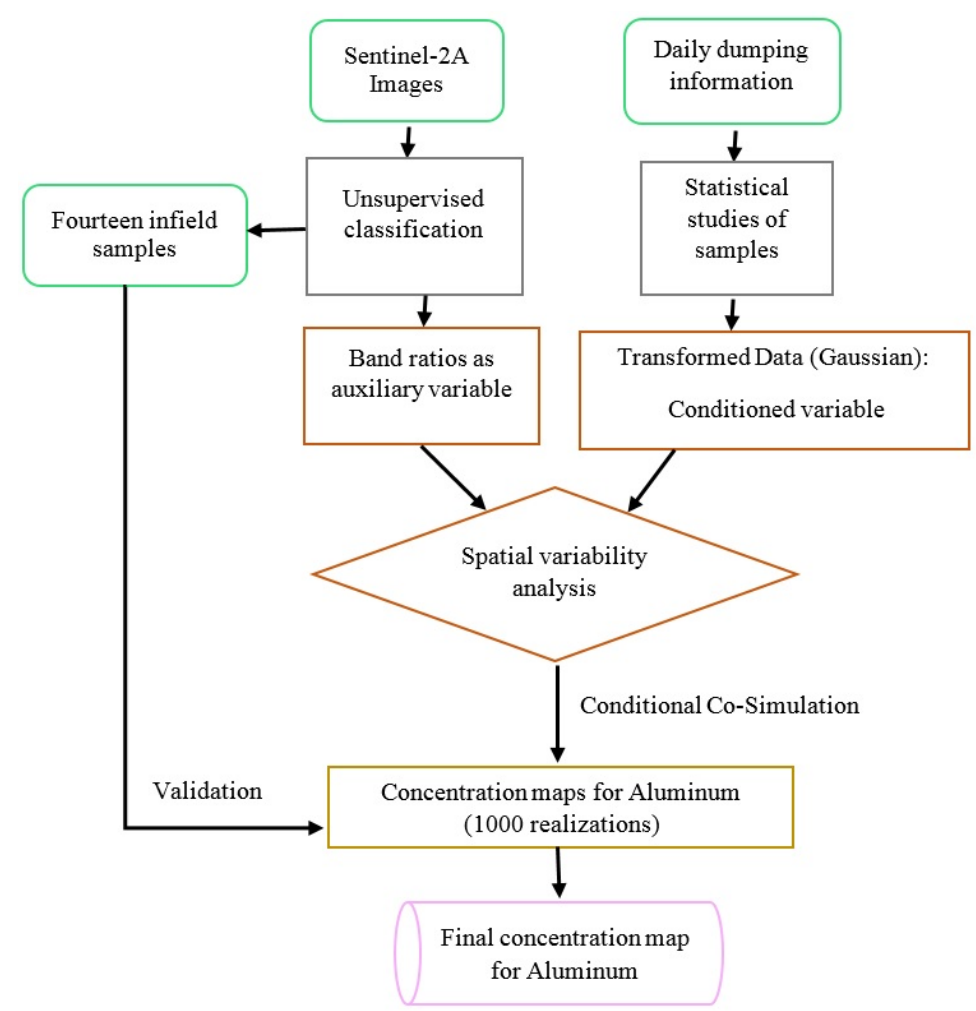
Figure 1. Proposed approach for mapping metal concentrations, by merging geostatistical conditional simulation and remote sensing analysis.